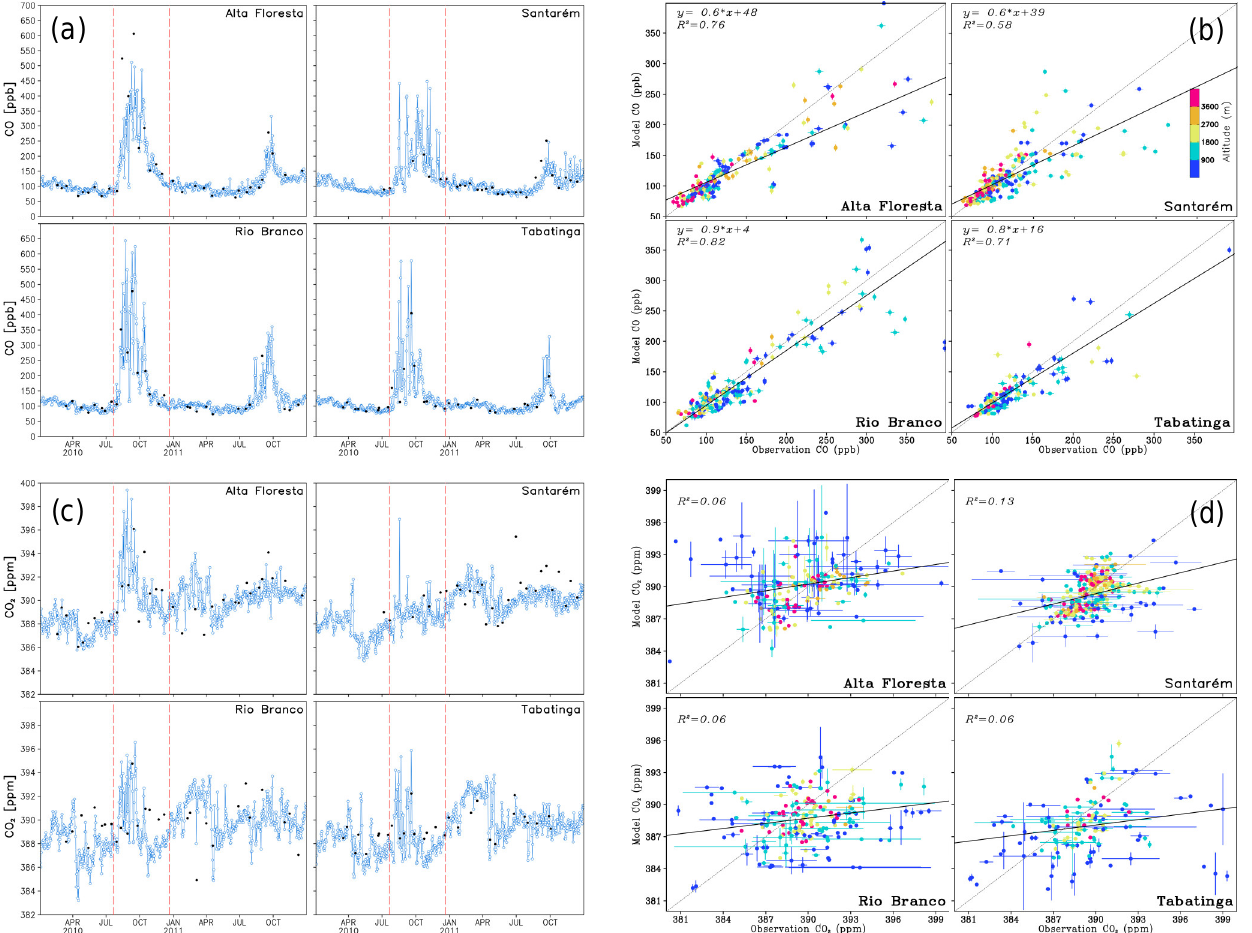
Figure 7. Time series (a, c) and scatterplots (b, d) of CO (ppbv; a , b ) and CO 2 (ppbv; c , d ) airborne measured (black dots) and simulated (DIR+DIF experiment, blue dots and line) at Alta Floresta, Santarém, Rio Branco, and Tabatinga (indicated on each plot) at about 2km above the ground level from April 2010 to October 2011. On the time series, the red dashed lines indicate the fire season of 2010. On the scatterplots, the colors scale depicts the vertical layers: < 900m (purple), 900–1800m (blue), 1800–2700 (green), 2700–3600 (orange), and > 3600m (pink), and the error bars refer to the standard deviation of the mean values. The locations of the measurement sites are indicated in Fig. 2.